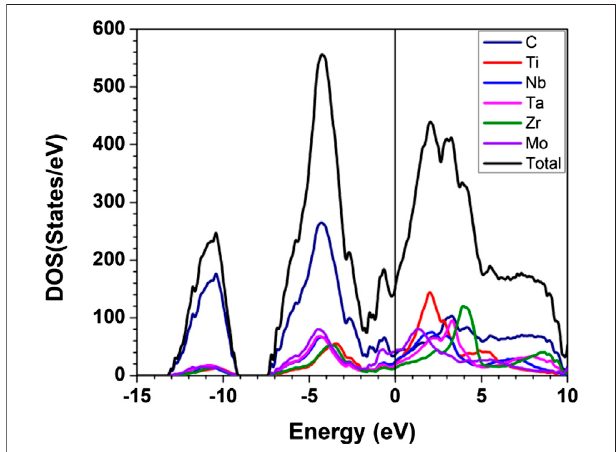
FIGURE 2 | Calculated partial and total density of states for m1. The straight black line indicates the DOS at Fermi